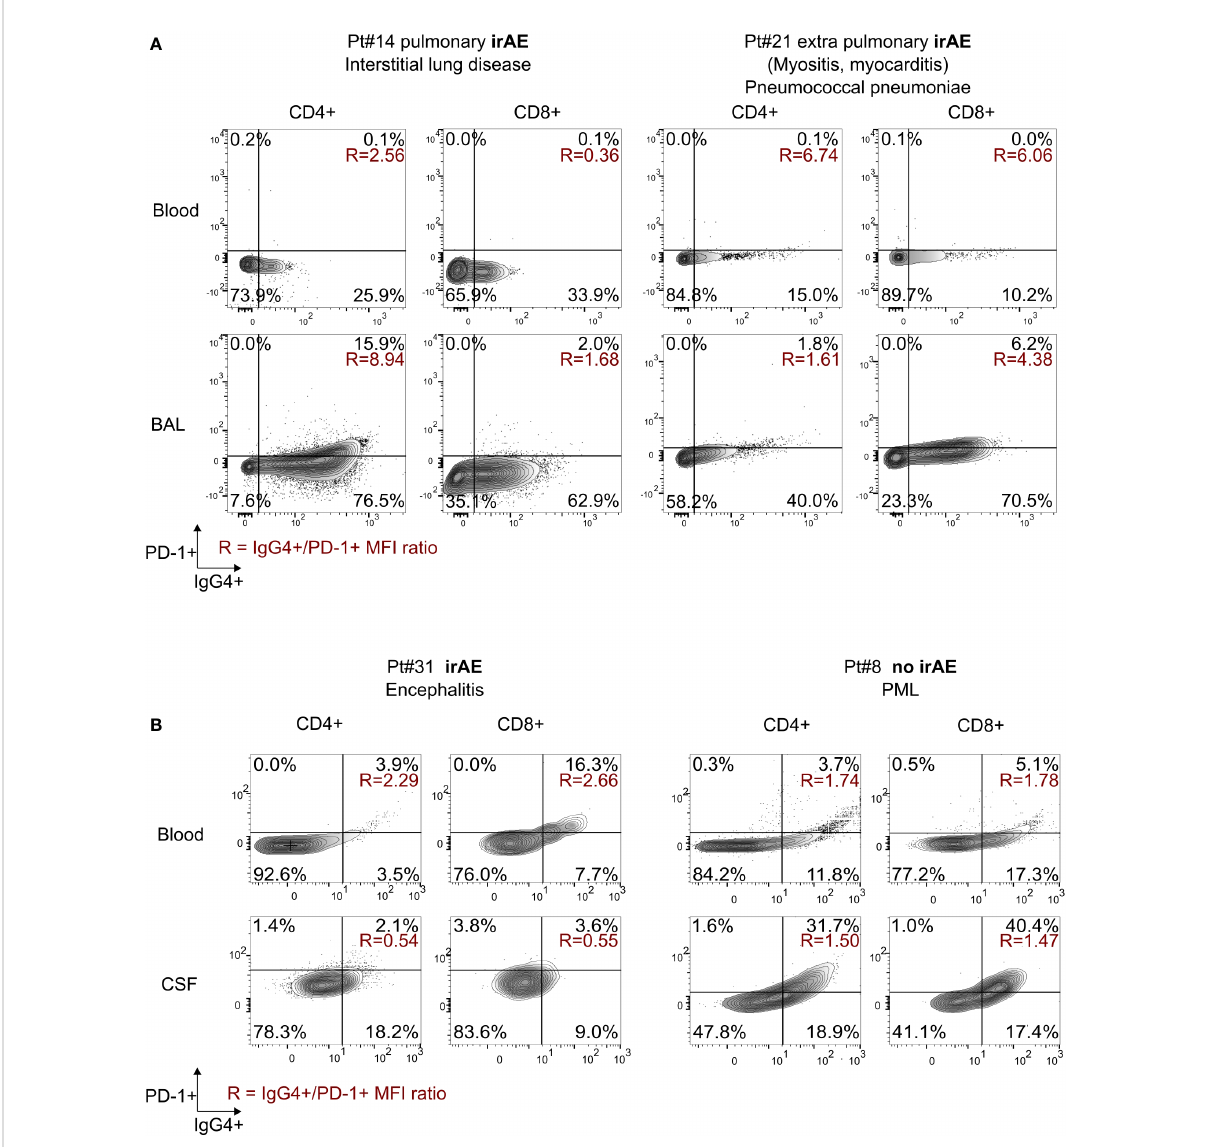
FIGURE 3 Flow cytometry analysis in other body fl uids. (A) Analysis of cells from BAL and blood of two patients with pulmonary affection, one related to ICI and one non-ICI related; (B) analysis of cells from CSF and blood of two patients treated with pembrolizumab for PML (Pt#8) or colorectal cancer with encephalitis (Pt#31). IgG4, PD-1, and double staining PD-1+IgG4+ levels in CD4+ and CD8+ T cells. Population percentages ; IgG4+ to PD-1+ MFI ratios are shown in red. BAL, bronchoalveolar lavage; CSF, cerebrospinal fl